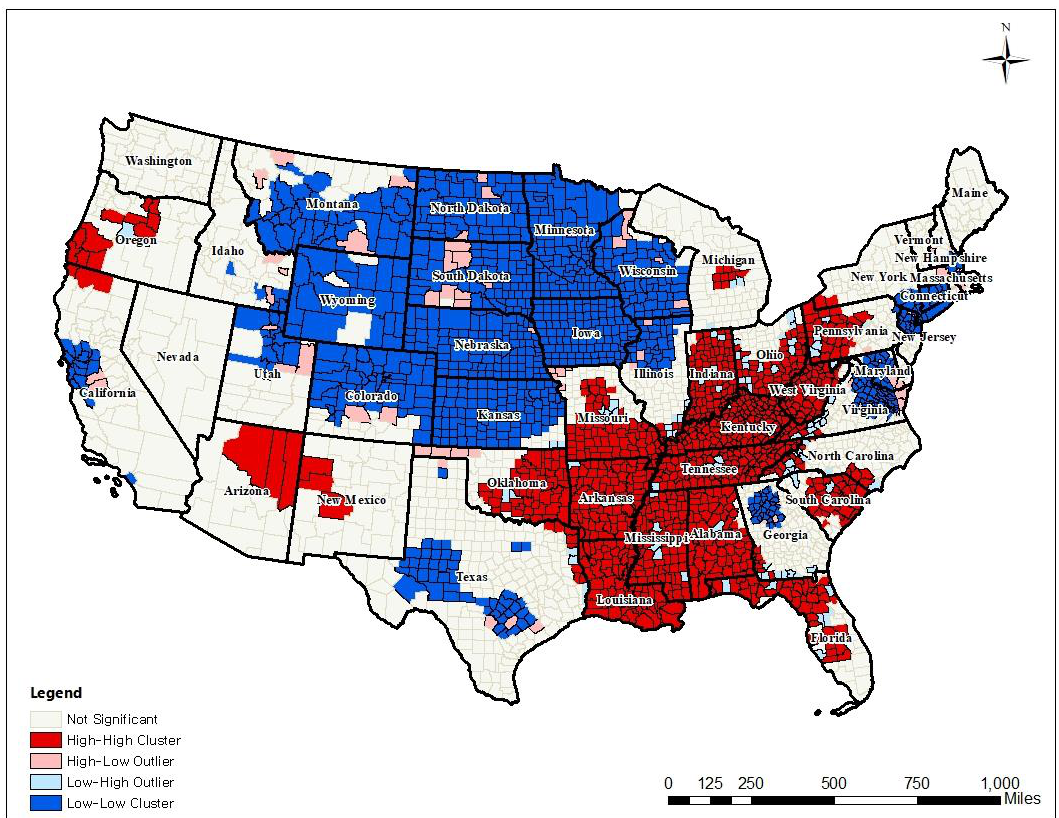
Figure 2. Spatial clustered patterns of poor mental health days.